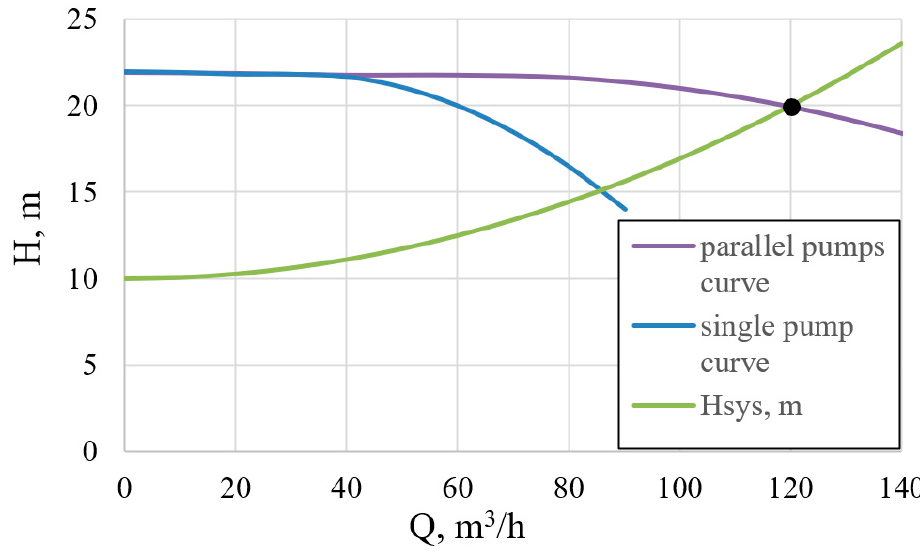
Figure 4. Determination of an operating point of the parallel pump system.